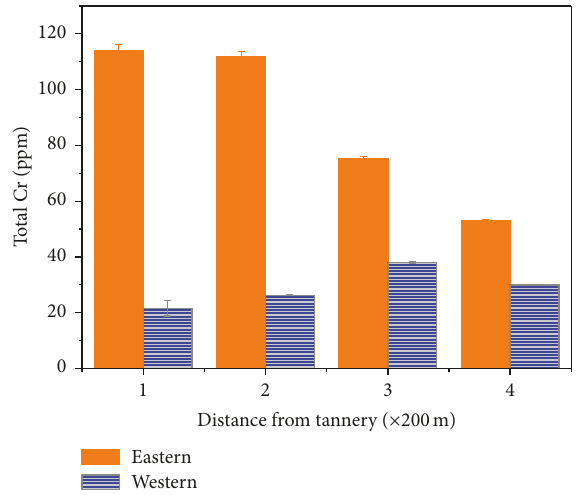
Figure 3: The pH of the corroded corrugated iron materials collect- ed at different distances from the tannery discharge